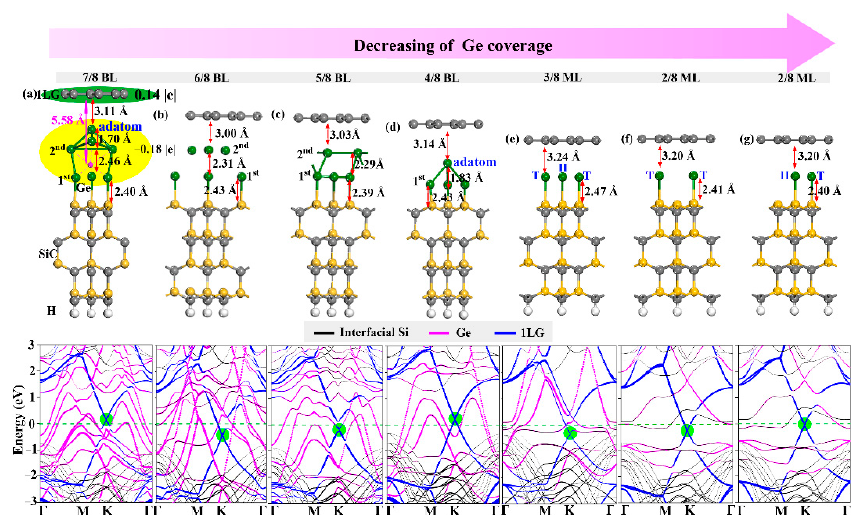
Figure 1. ( a – g ) Structures and band structures of 1LG/Ge/SiC with different Ge locations and coverages. In ( a ), Bader charges ( e ) carried by 1LG (green area) and Ge intercalation (yellow area) have been labeled. The rose red ball represents the mass center of the intercalation. In the band structures, the pink, blue, and black lines represent the contribution of Ge intercalation, 1LG, and interfacial Si of SiC substrate, respectively. The green circles show the graphene Dirac point.